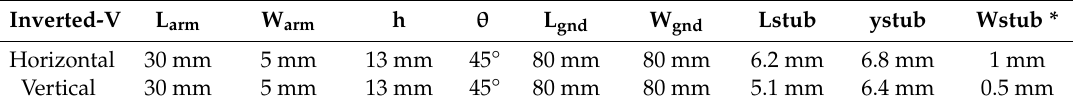
Table 1. Design parameters of the proposed inverted-V antenna.